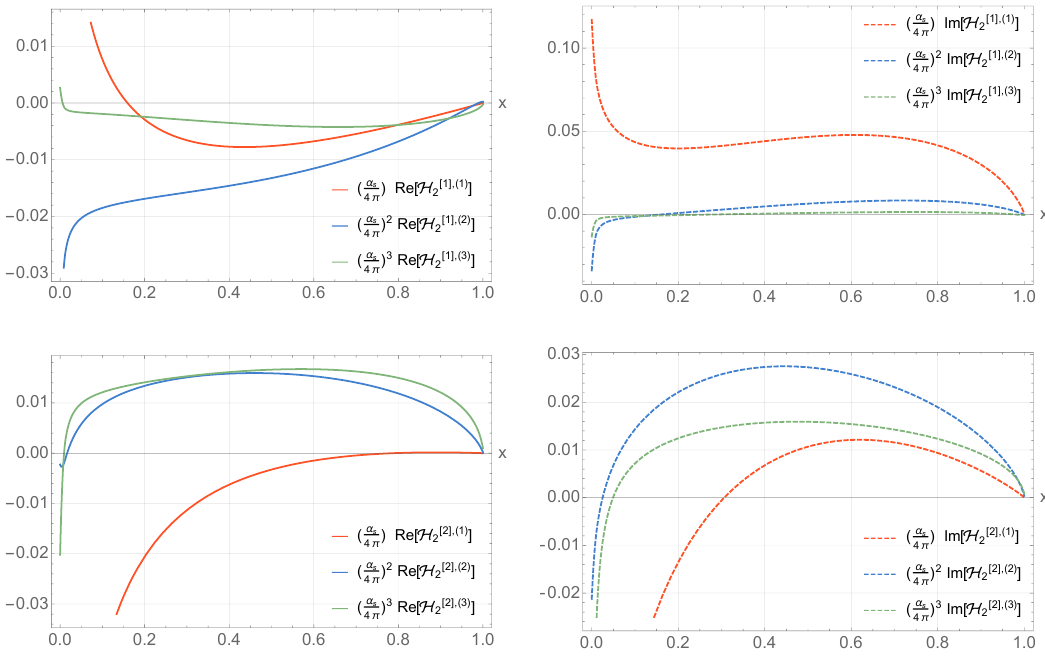
relevant for helicities 2 , fin while the index [2] δ i 1 i 4 i 2 i 3